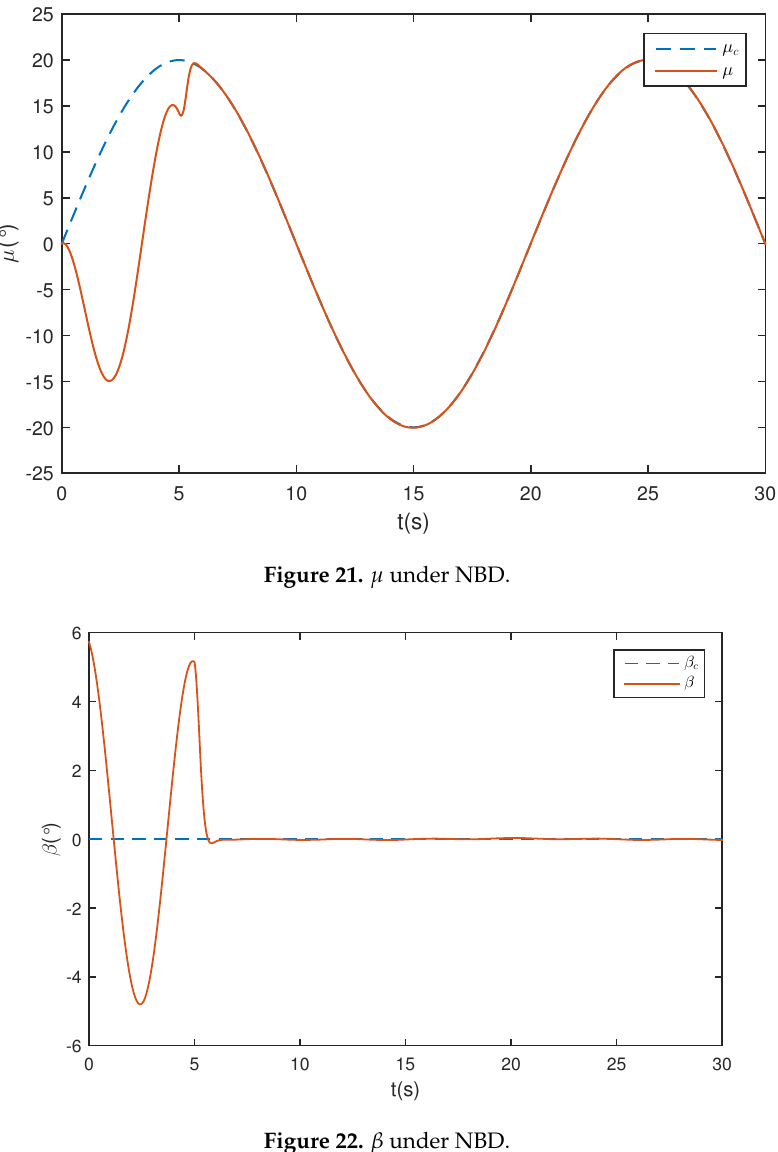
Figure 22. β under